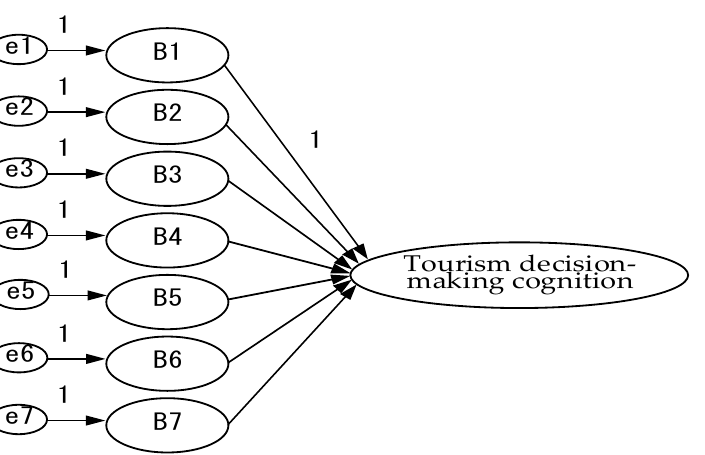
Figure 2. Tourism decision-making cognition model—confirmatory factor analysis framework.